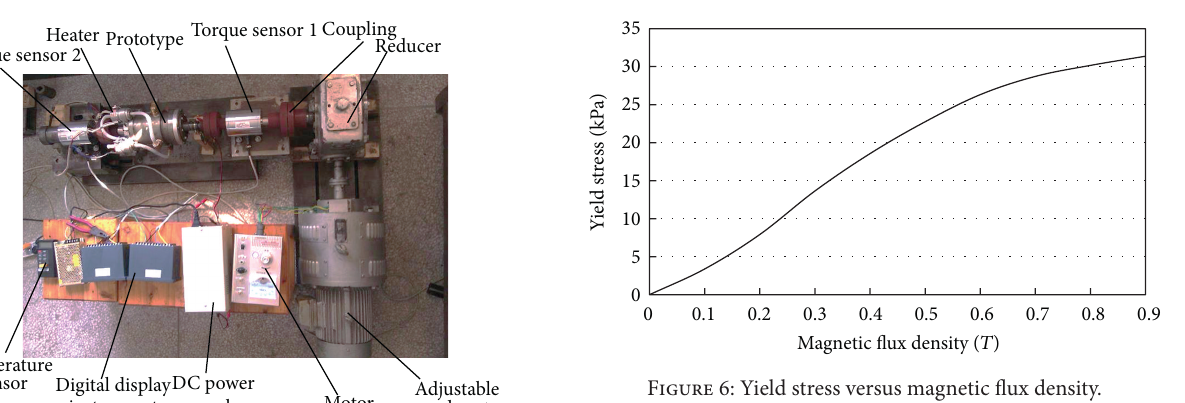
Figure 6: Yield stress versus magnetic flux density.